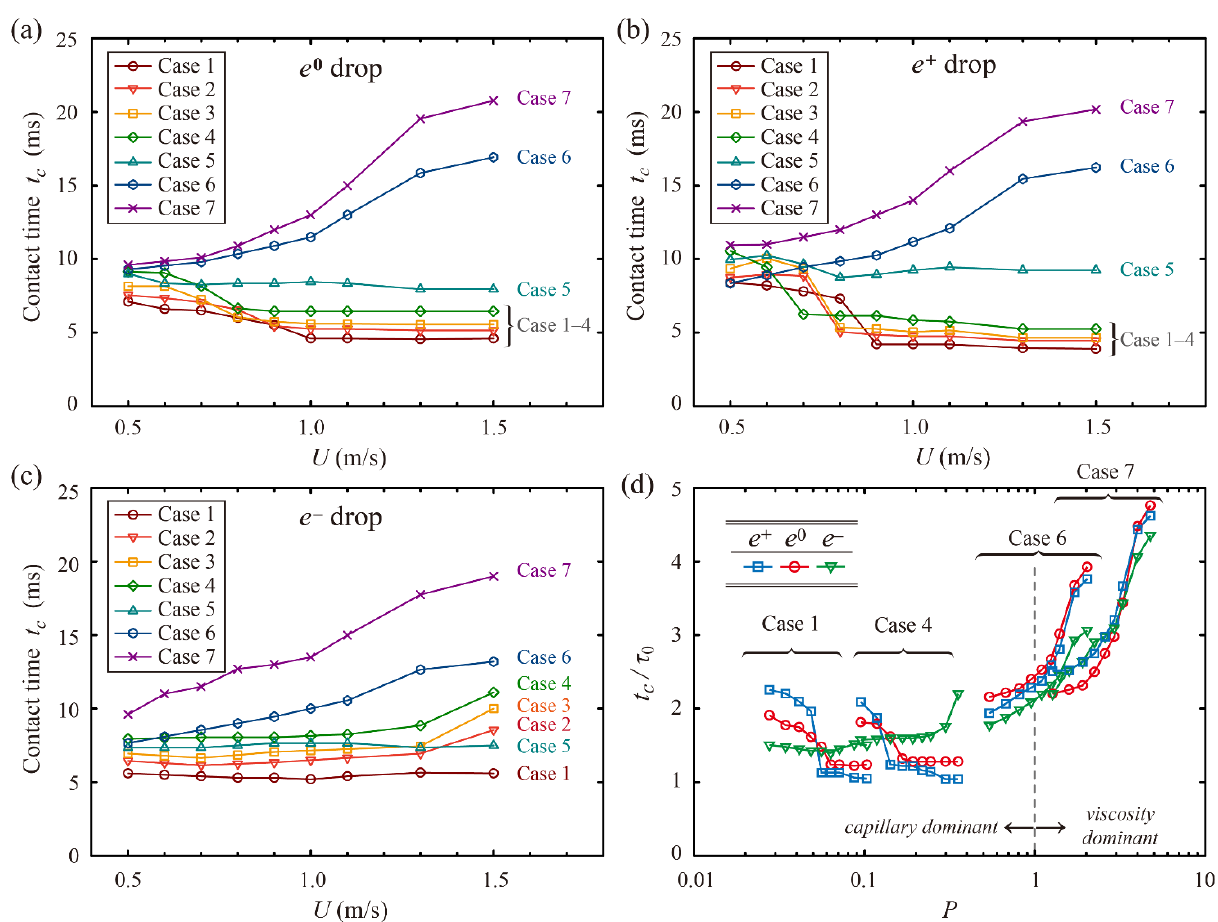
Figure 6. Effect of liquid properties on reduction in the residence time under various U for ( a ) spherical, ( b ) e + , and ( c ) e − drops. ( d ) Residence time normalized by τ 0 as a function of Impact number ( P = We / Re 4/5 ) for Cases 1, 4, and 6.